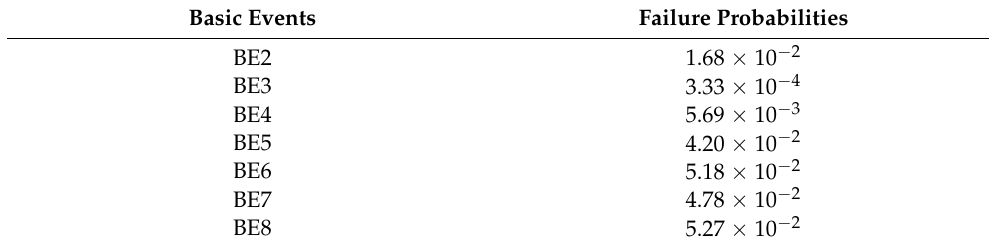
Table 12. Failure